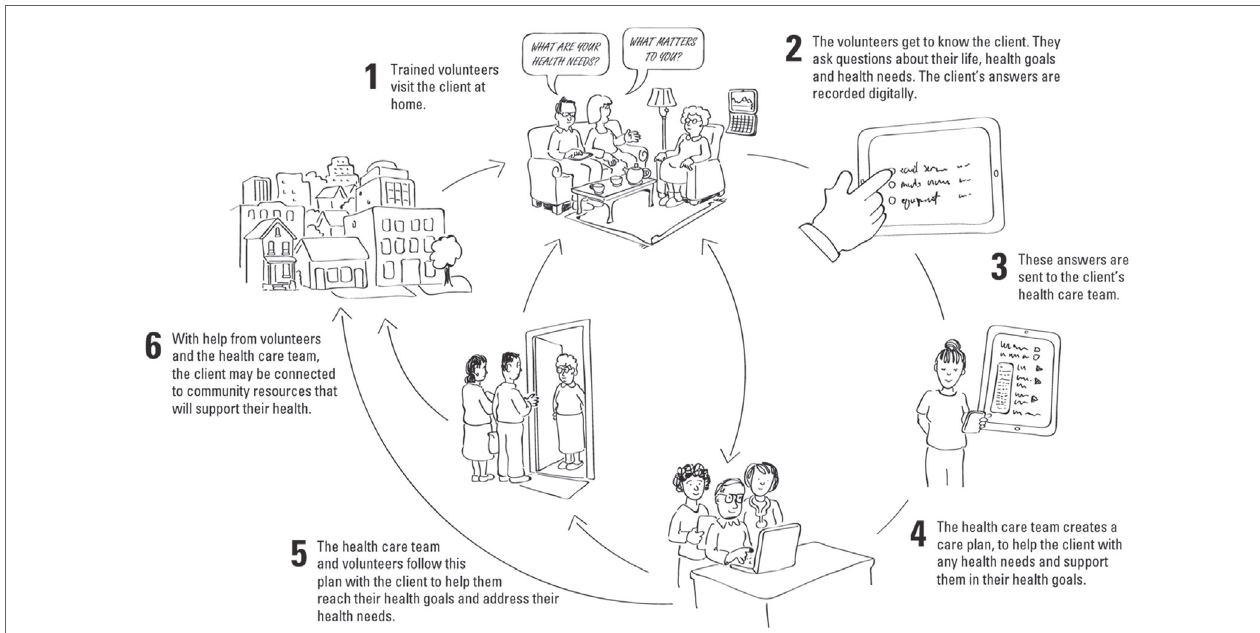
FiguRe 1 | Health TAPESTRY process. Volunteers visit clients in their home and use the Health TAPESTRY Application to collect information. This information is summarized on a Health TAPESTRY-report and is uploaded into the person’s electronic medical record to be shared with the interprofessional health care team at the clinic. Reports are viewed and an action plan is developed which can include community supports, volunteer follow-up visits, and follow-up in any nature (i.e., phone call, clinic visit) by health care team, including the personal health record